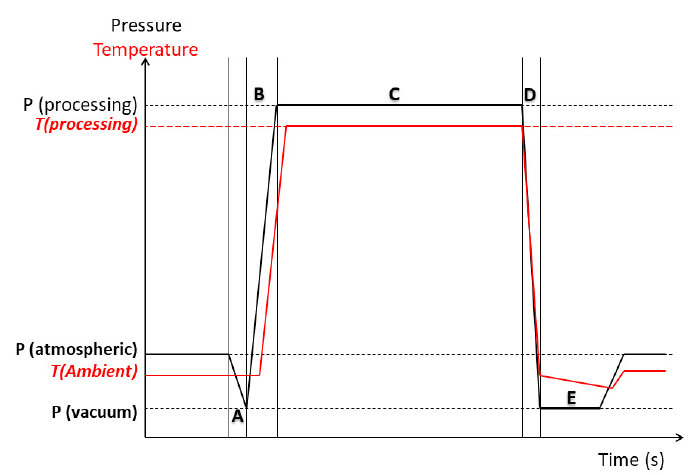
Figure 9. Schematic time-pressure profiles of a DIC processing cycle. (A): The establishment of the vacuum; (B): the injection of steam; (C) maintained treatment pressure during the selected thermal processing time; (D): Instant Controlled Pressure Drop towards the vacuum; (E): the establishment of the atmospheric pressure.